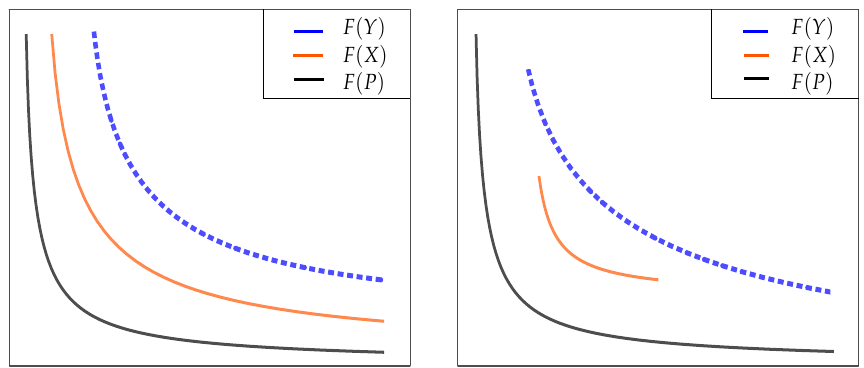
Figure 6. ( Left ) A situation where the Pareto front F ( P ) and the images F ( X ) and F ( Y ) of continuous archives satisfy I GD p , q ( X ) (cid:54) I GD p , q ( Y ) and condition 1( a ) of Theorem 8 holds true. ( Right ) A modification of the previous situation where conditions ( a (cid:48) ) and ( b (cid:48) ) of Remark 6 are satisfied but I GD p , q ( X ) (cid:10) I GD p , q ( Y ) . Here, there are no possible partitions of the archives satisfying part 1( a ) of Theorem 8.